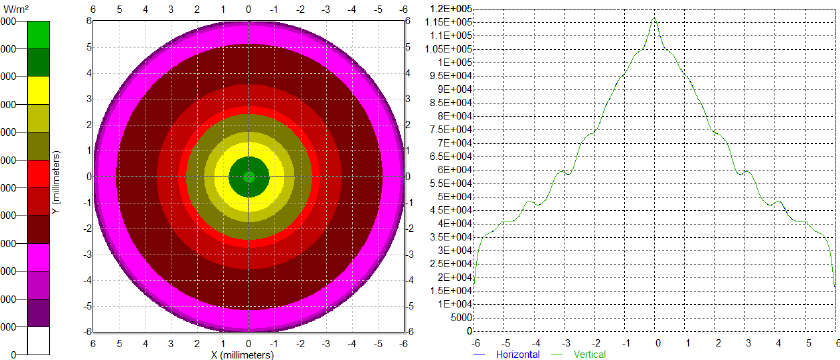
Figure 3. Modeled irradiation distribution on the catalyst surface: ( left ) schematic, ( right ) numeric.